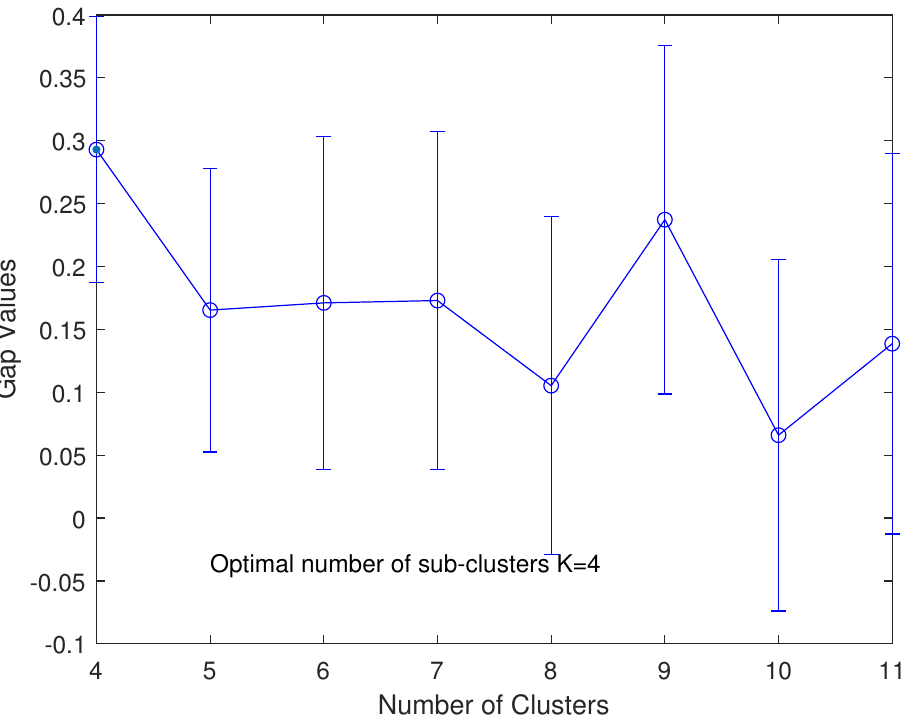
Figure 2. Optimized number of subclusters using the gap statistic method, the optimal number of clusters at K = 4 satisfying the first maximum standard error.